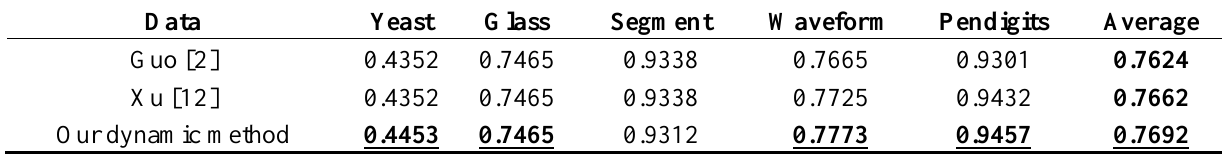
Table 10. Correct classification rates of three methods using dynamic discounting